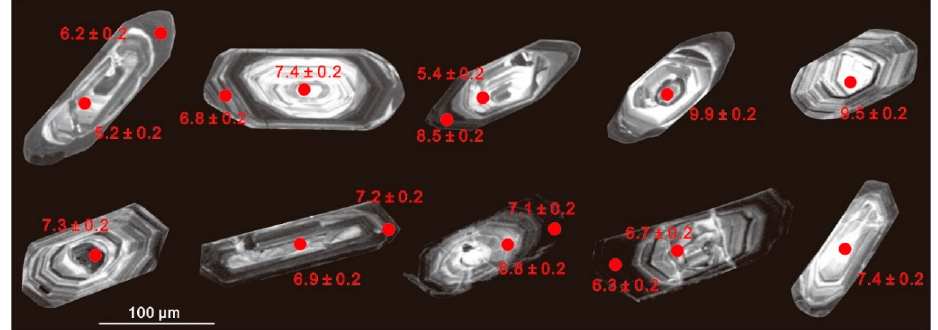
Figure 5. Cathodoluminescence (CL) images of representative zircons from the two-mica granite (first row) and the biotite granite (second row). Circles indicate the location of ion microprobe analysis spots, δ 18 O values are beside each circle.